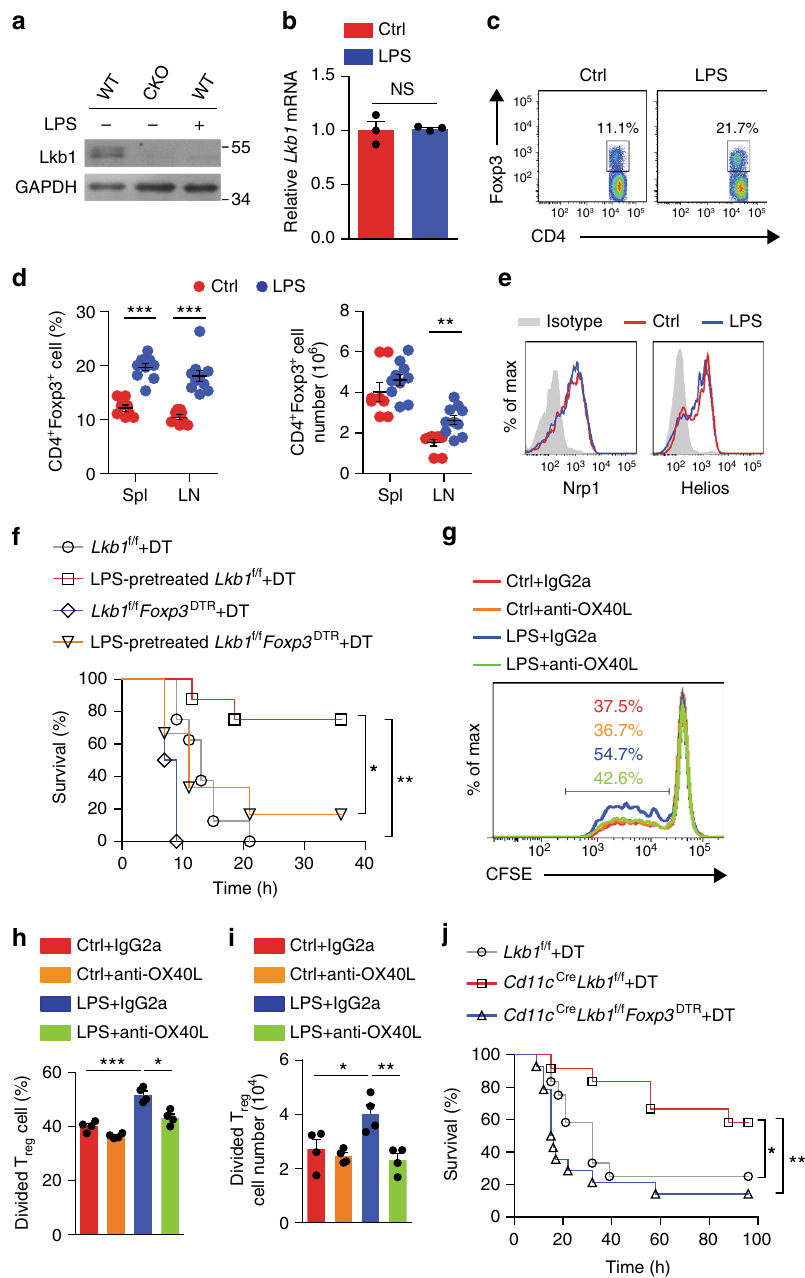
Fig. 6 LPS induces T reg cell expansion and suppression through depleting Lkb1 in DCs. a Lkb1 protein in splenic DCs from Lkb1 f/f (WT) and Cd11c Cre Lkb1 f/f (CKO) mice treated or untreated with LPS (1.5 mg kg − 1 ) overnight. b mRNA level of Lkb1 in splenic DCs from mice with or without LPS treatment. c Representative T reg cell frequencies among splenic CD4 + T cells from mice treated with or without LPS 5 days in advance. d Quanti fi cation of the percentage and absolute number of T reg cells in the spleen and LNs of mice treated with or without LPS 5 days in advance (Ctrl, n = 8; LPS, n = 10). e Expression of Nrp1 and Helios in splenic T reg cells from mice with or without LPS treatment 5 days in advance. f The survival curve of Lkb1 f/f ( n = 8 each group) and Lkb1 f/f Foxp3 DTR mice ( n = 6 each group) pre-treated with or without LPS (5 days in advance), treated with DT (50 μ g kg − 1 , 2 days in